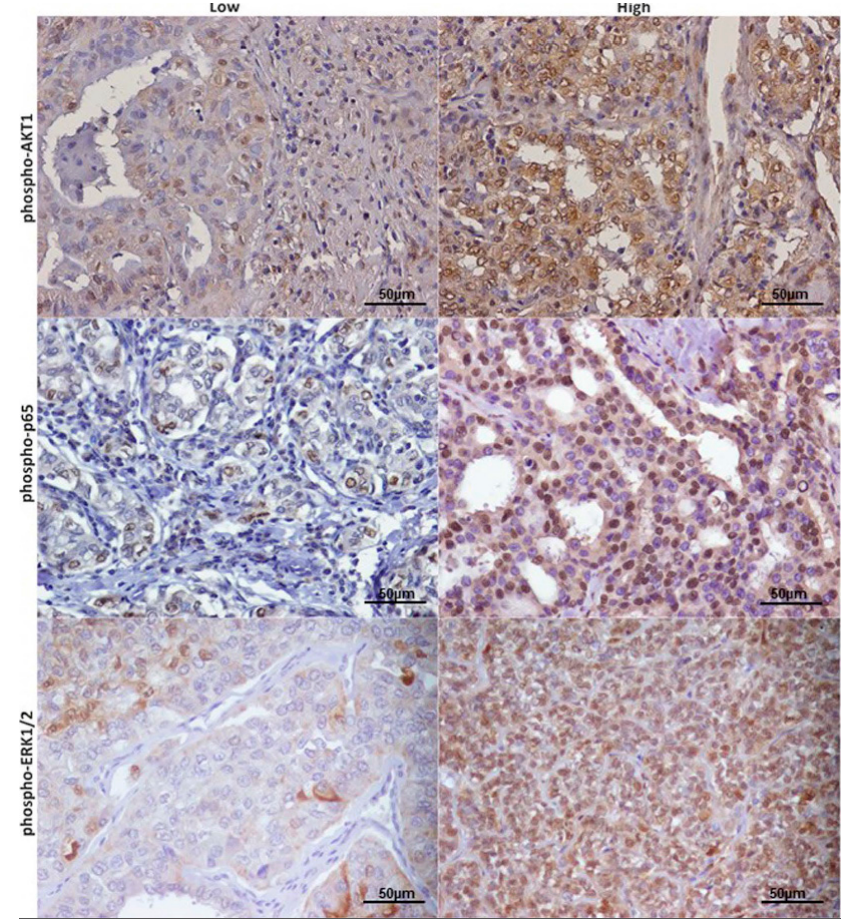
Figure 5. Signaling pathway activation in thyroid cancer samples. Immunohistochemical staining of representative Papillary thyroid carcinoma (PTC) samples with anti-phospho-AKT1, anti-phospho-p65 NF-kB, anti-phospho-ERK1/2 at 40× magnification, scale bar = 50 μ m. High and low staining for each protein are defined as described in the Materials and Methods section.